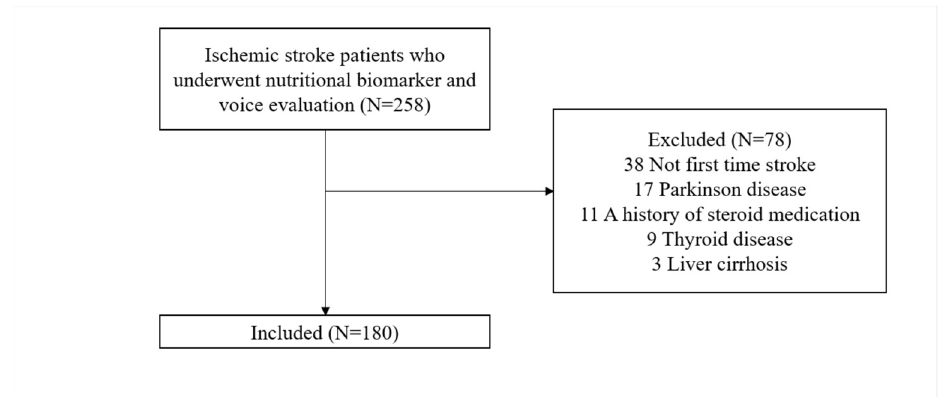
Figure 1. Flow chart of study participants enrollment.